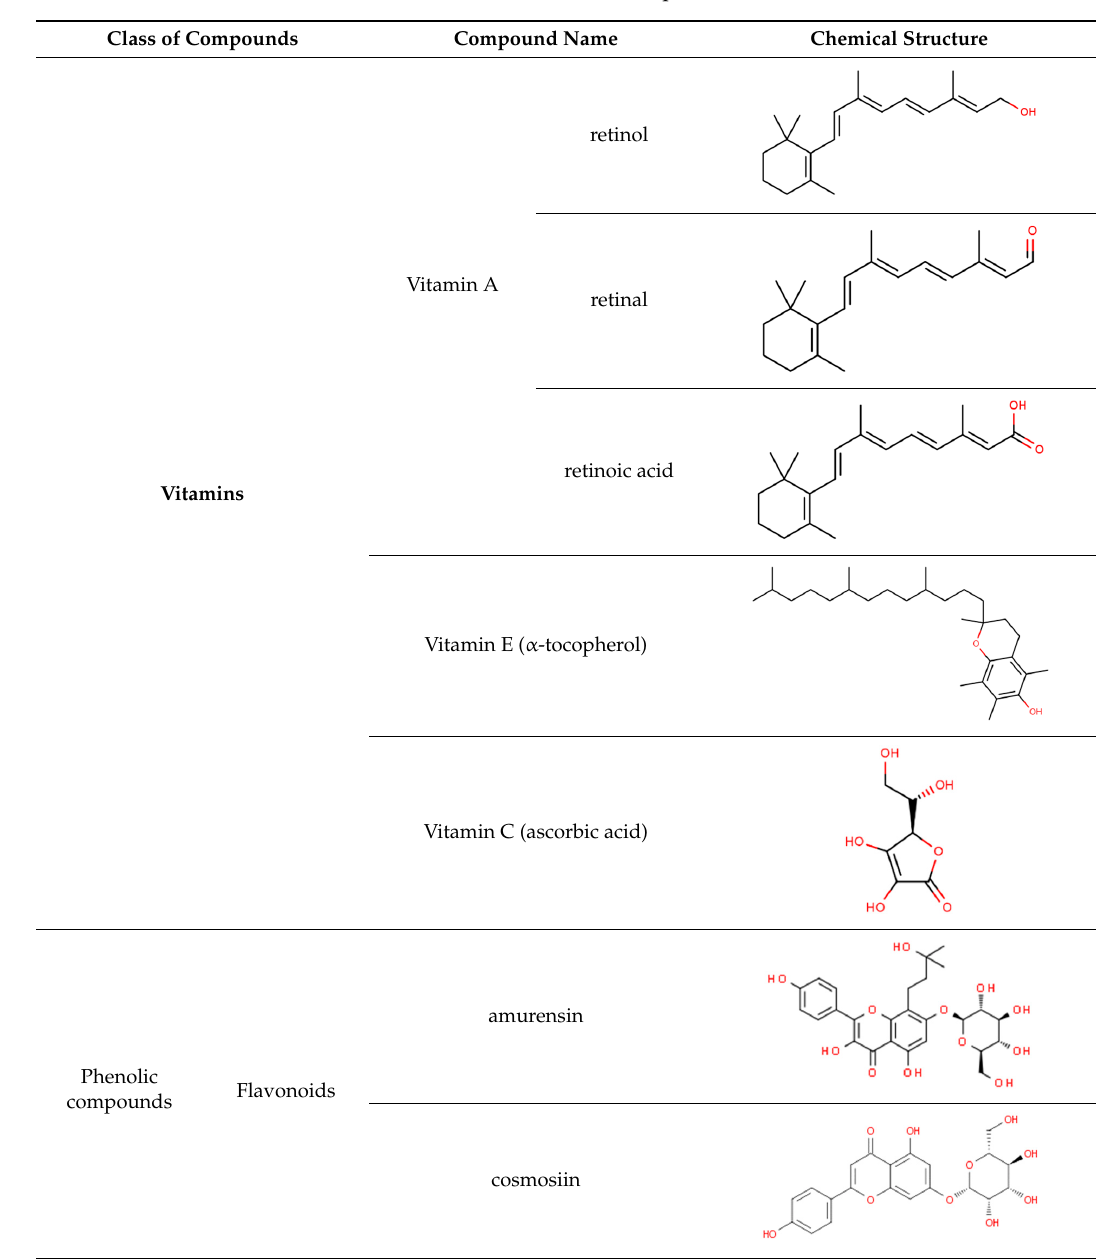
Table 1. The most common antioxidant molecules in neuroprotection and their chemical structure.